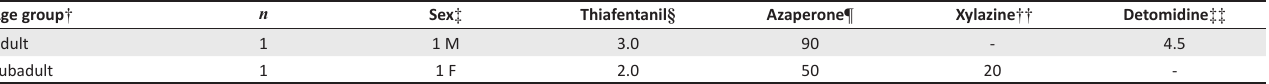
TABLE 1b: Immobilising drug combinations and doses used for free-ranging black rhinoceros in Zimbabwe. Doses (in mg) for black rhinoceros immobilised with thiafentanil, azaperone, and xylazine or detomidine. Age group †